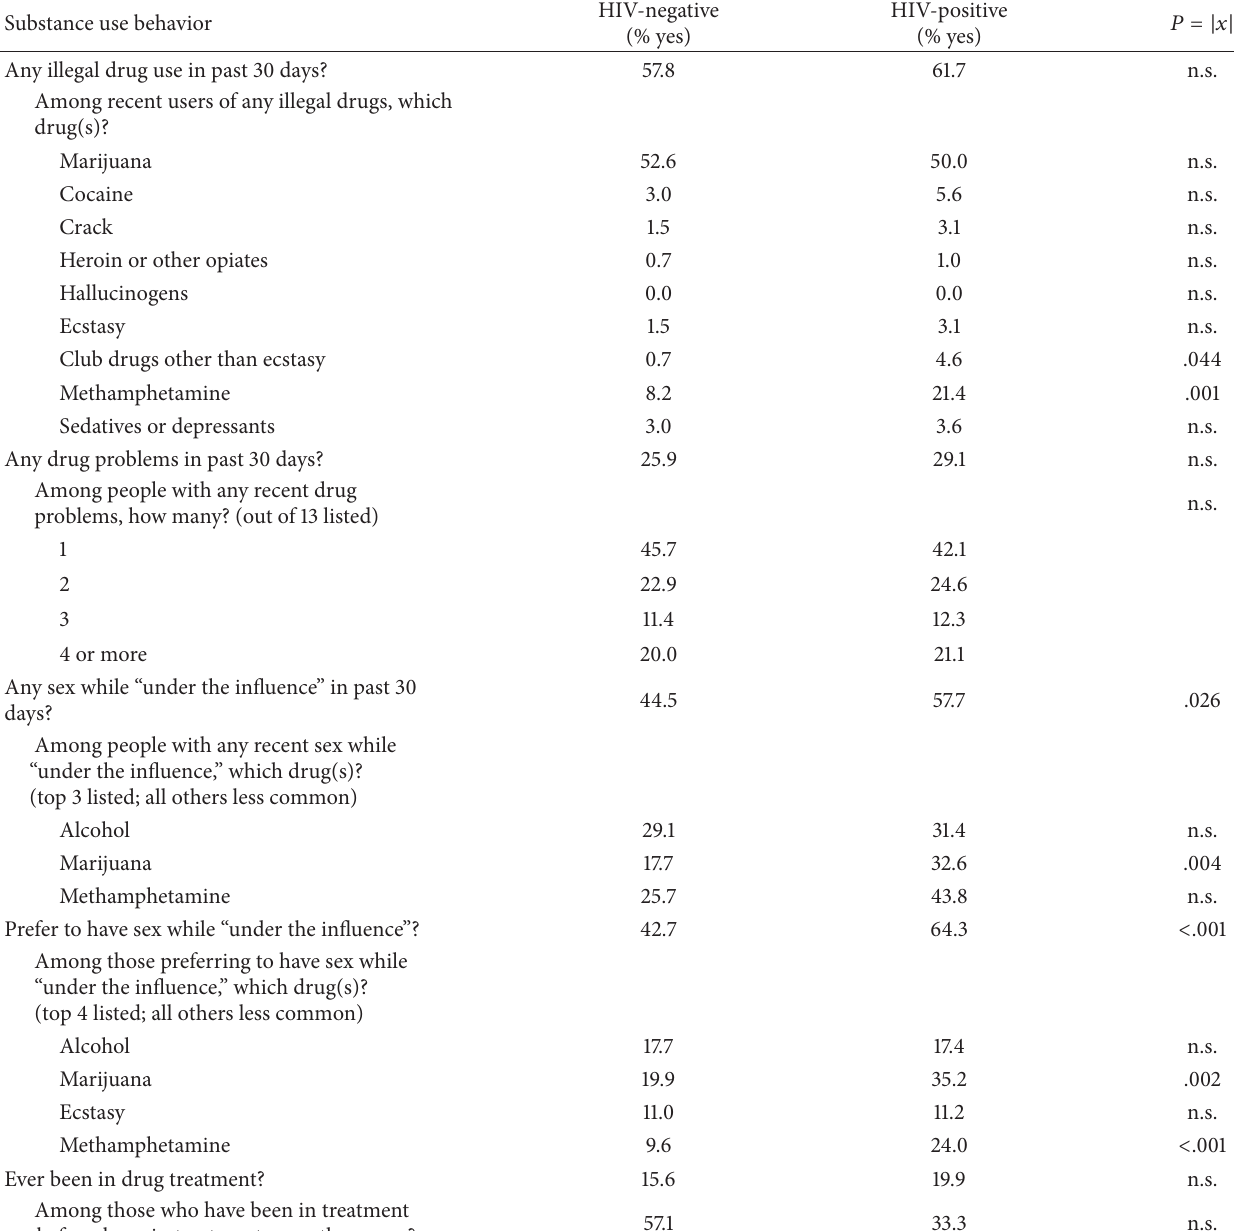
Table 5: Differences between HIV-positive and HIV-negative men in substance use